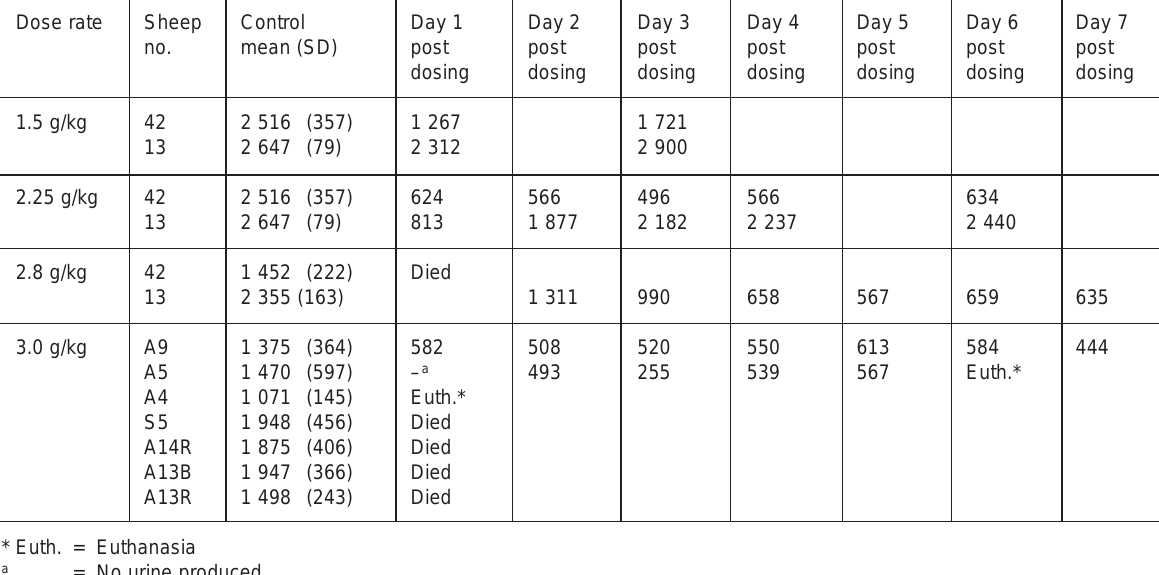
TABLE 5 Urine osmolarity (mOsm/ l ) of sheep—control values and values following dosing with Nolletia gariepina Dose rate Sheep